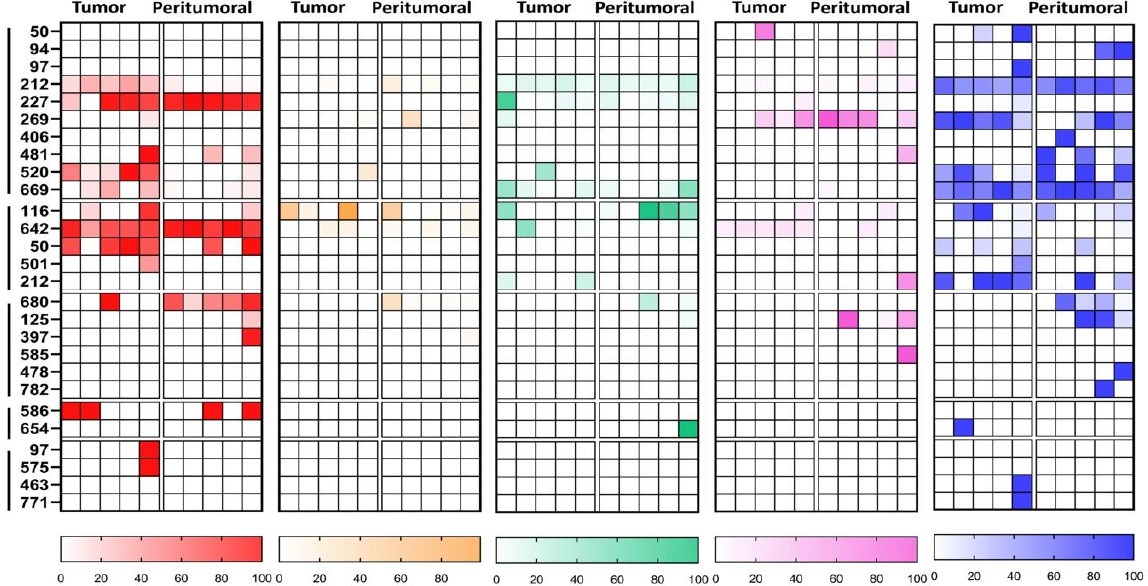
Figure 5. Site ‐ specific N ‐ glycosylation of selected integrin glycoproteins—ITB1, ITB2, ITB3, ITB5, and ITB6—compared between tumor and peritumoral tissues and categorized according to the type.